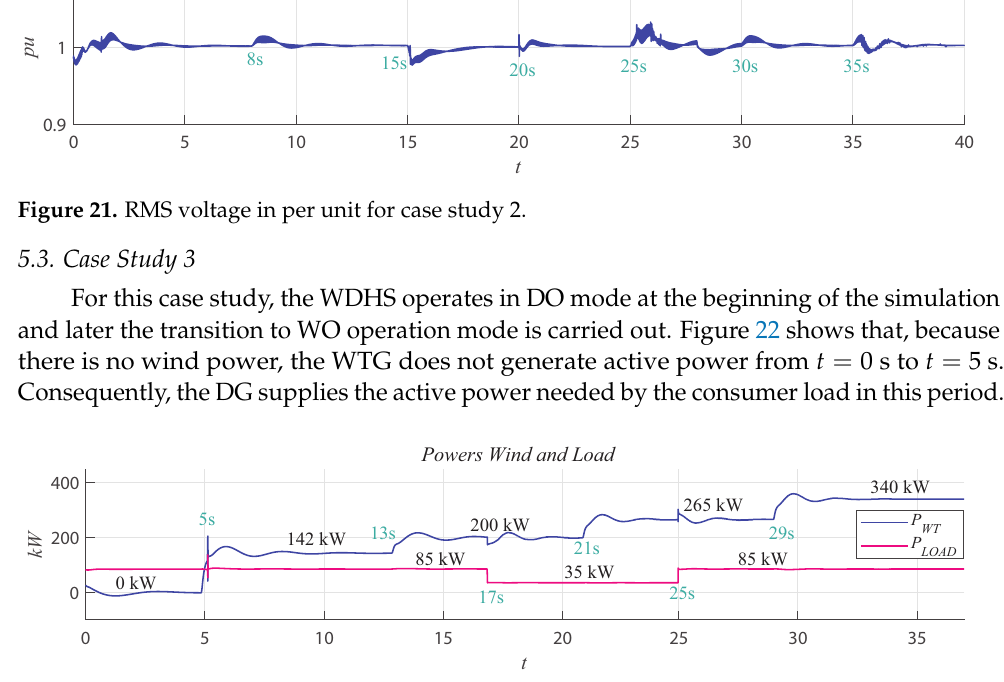
Figure 22. Power wind and load for case study